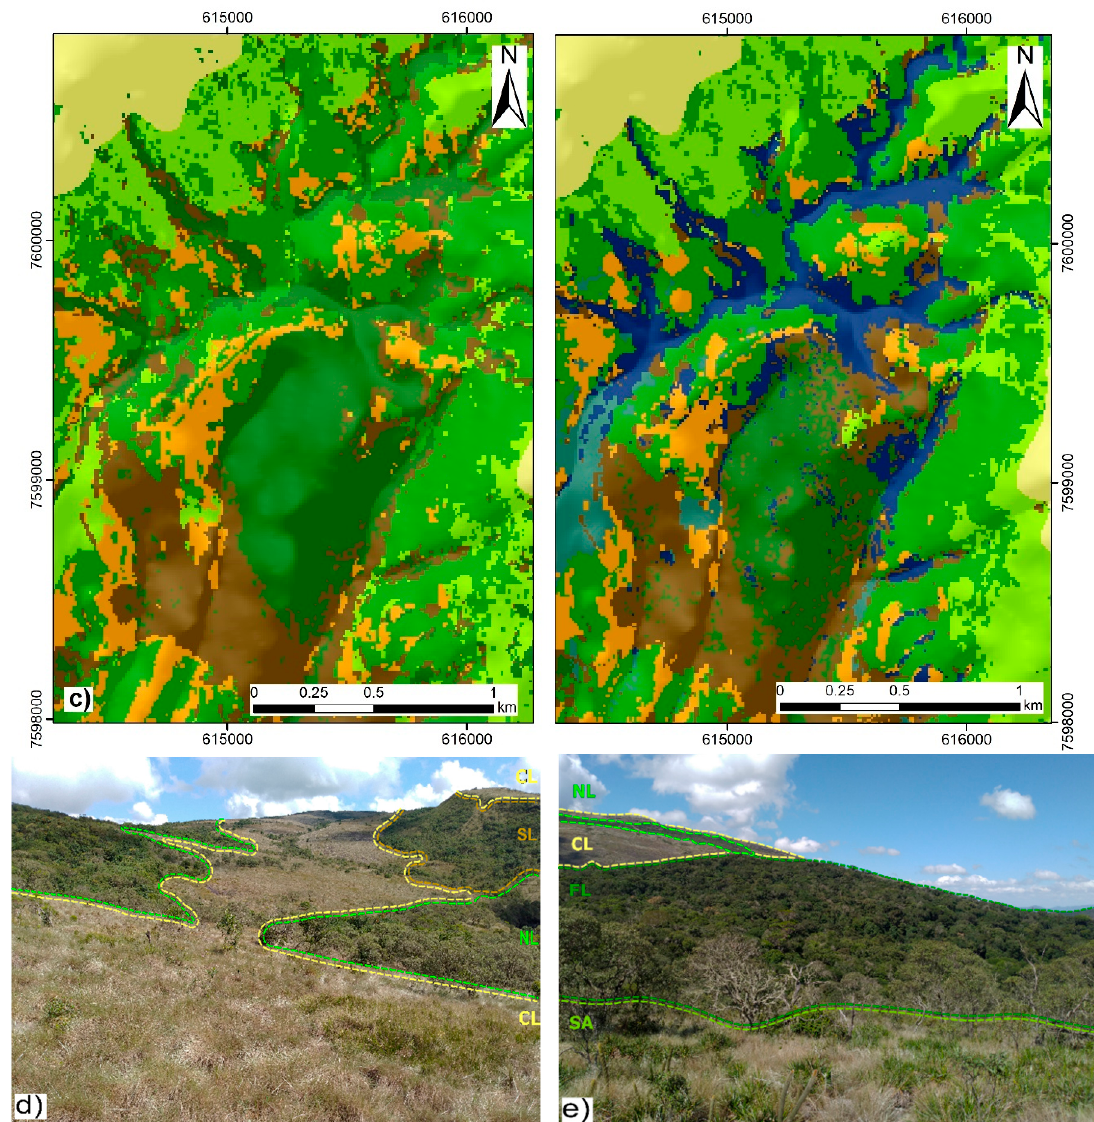
Figure 7. Maps of phytophysiognomies at the Ibitipoca State Park, Brazil. ( a ) First Taxonomic Level (phytophysiognomies); ( b ) Fifth Taxonomic Level (phytophysiognomies + soil depth); ( c ) central portion of the area highlighting differences among formations for both taxonomic levels; ( d ) photo highlighting north sight: Bushy grassland (CL), Parkland savanna (SL), Broad-leaved dwarf-forest (NL) and Shrubland savanna (SA); ( e ) photo highlighting southeast sight: Bushy grassland (CL), Broadleaved dwarf-forest (NL), Broadleaved forest (FL), and Broadleaved scrub (AL).